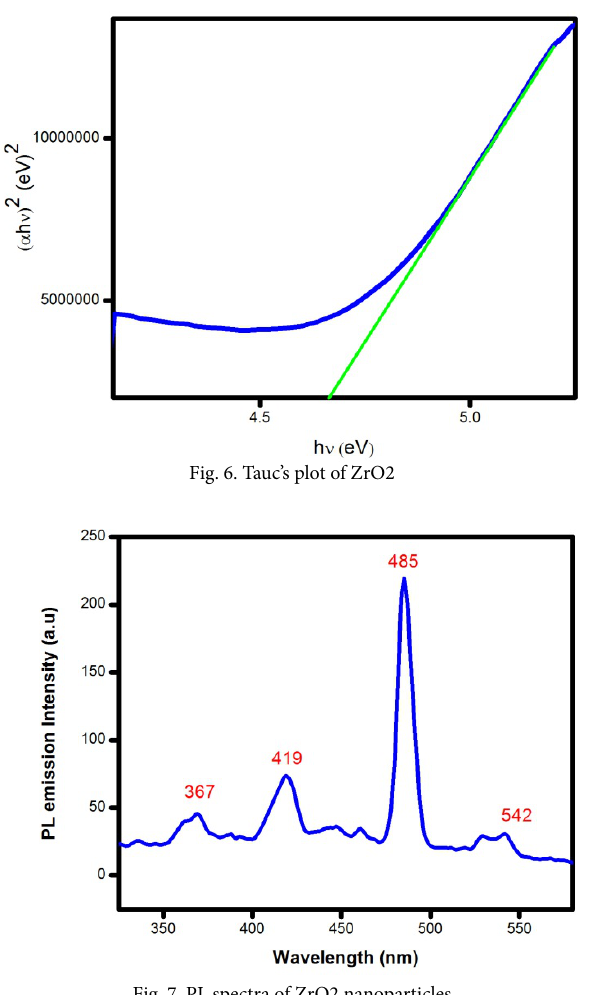
Fig. 7. PL spectra of ZrO2